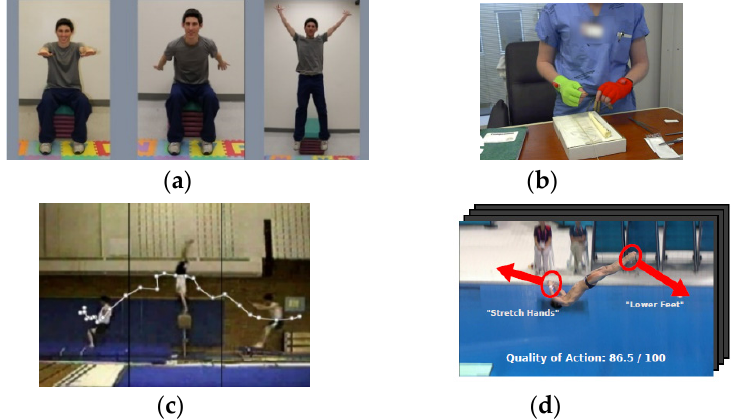
Figure 1. Several application fields of human action evaluation. ( a ) healthcare and rehabilitation; ( b ) surgical skill training; ( c ) sports skill training; ( d ) sports activity scoring.